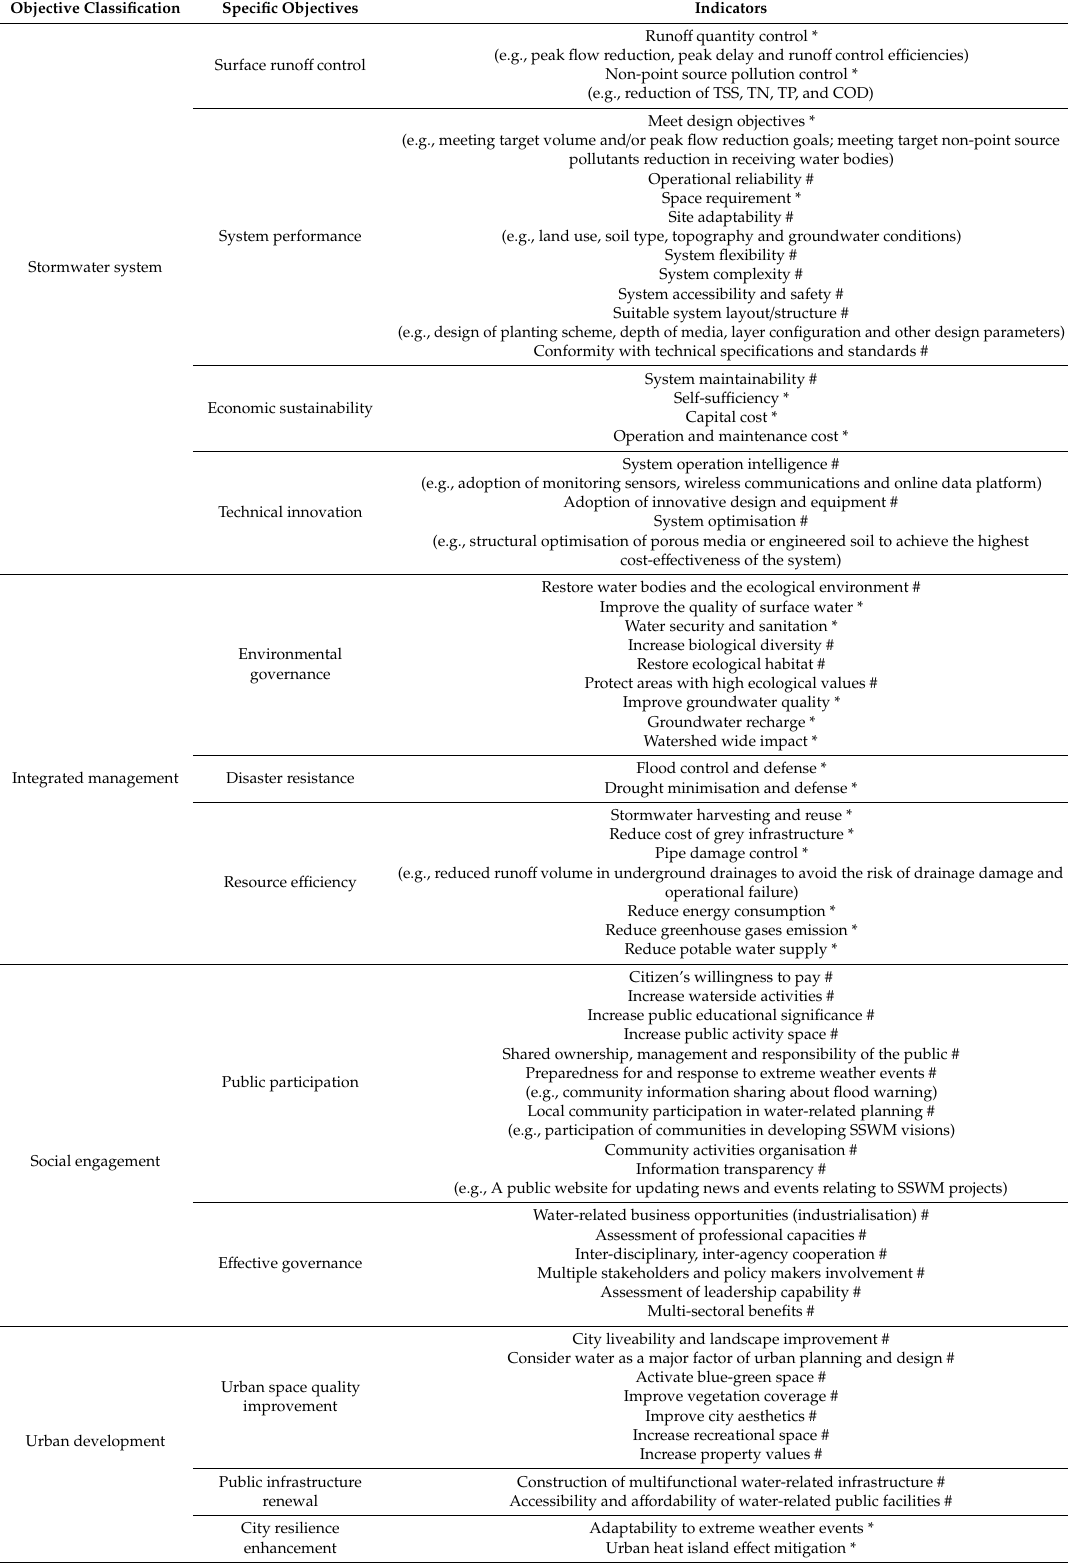
Table 1. Comprehensive evaluation framework for